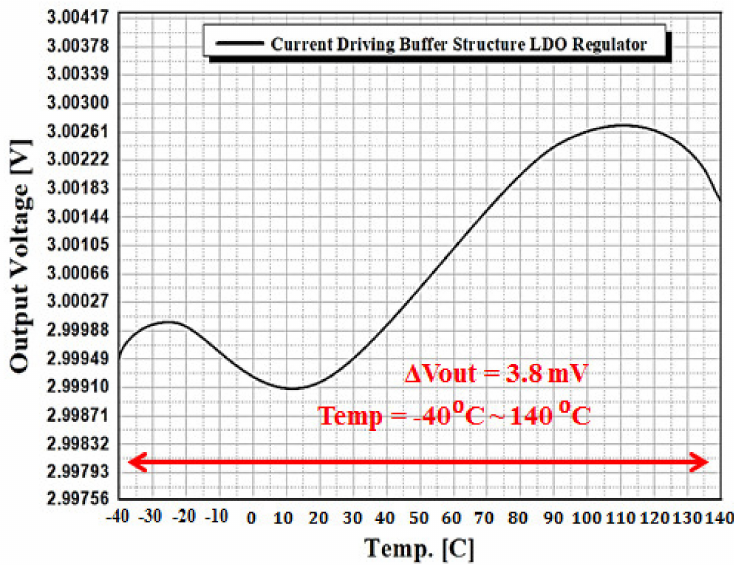
Figure 16. Temperature characteristics of the proposed LDO regulator.